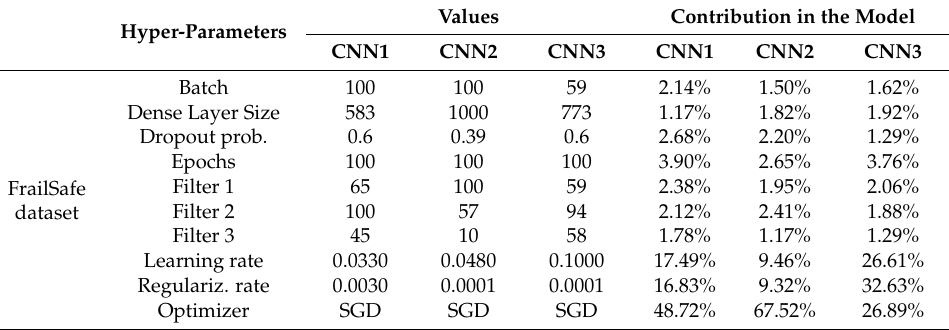
Table 4. Optimized hyper-parameters using SigOpt ( SGD : stochastic gradient descent).